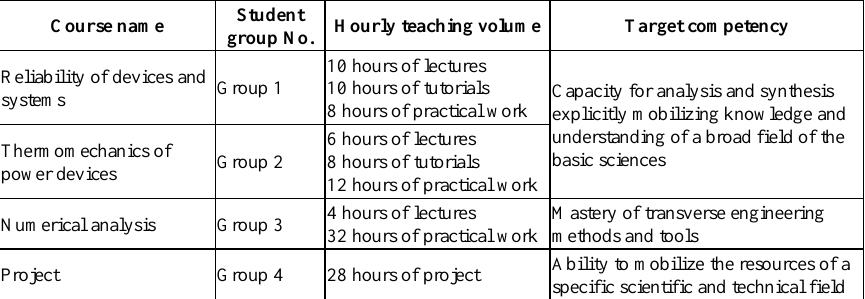
Table 2. Course selection and target